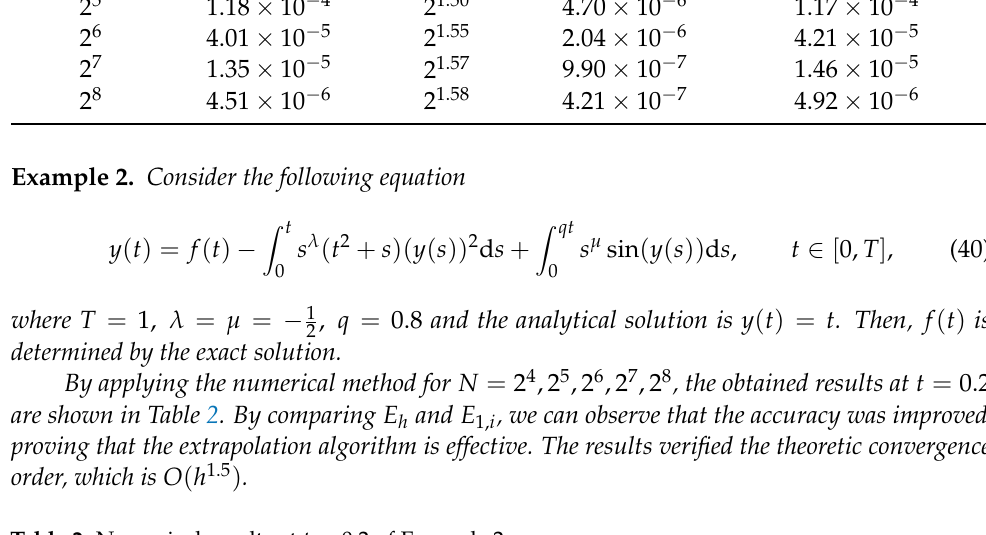
Table 2. Numerical results at t = 0.2 of Example